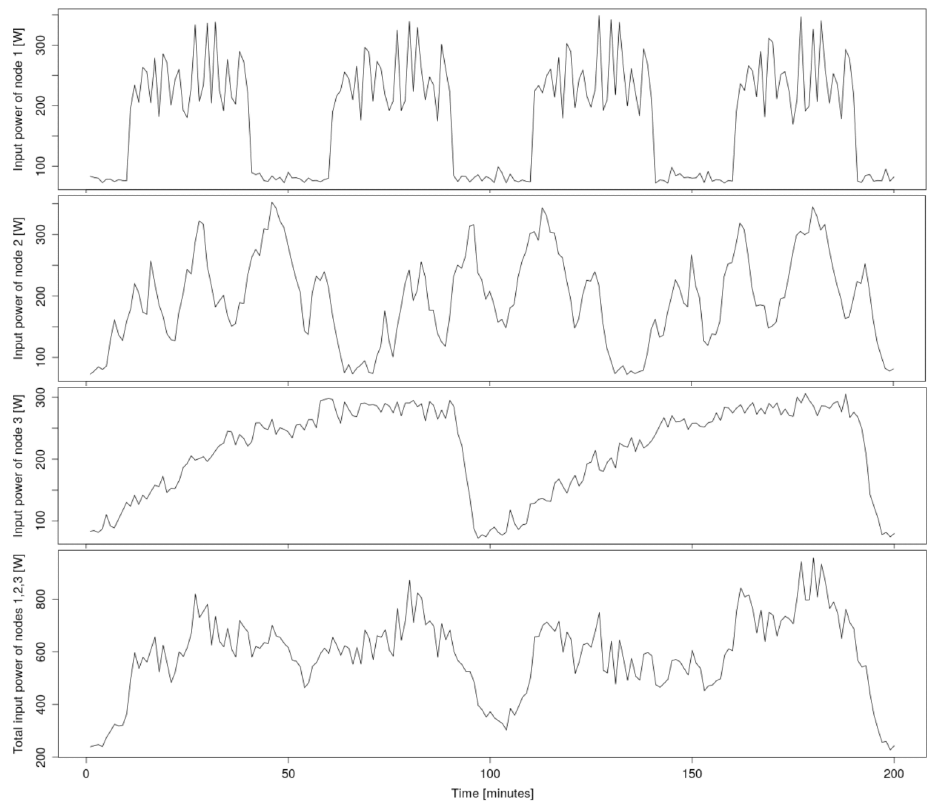
Figure 1. A simplified example of consumption aggregation. Energy consumption of 3 nodes running different jobs at the same time. Regular patterns merged together give a regular pattern, but the pattern is more complex, with a smaller degree of predictability.